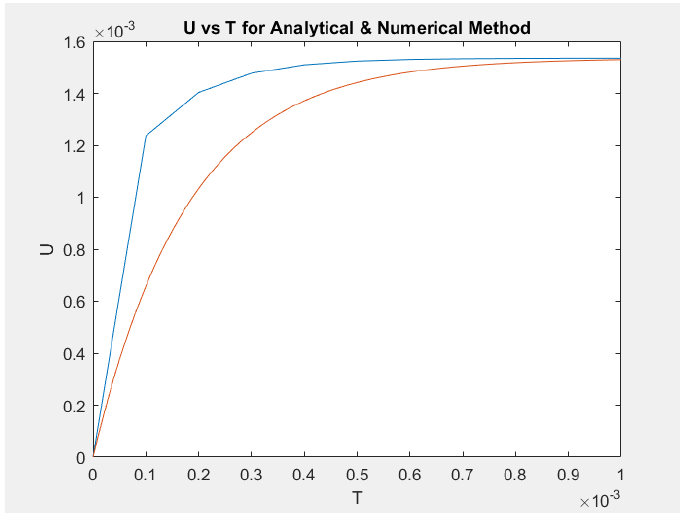
Figure 6. Variation in flexural strength.